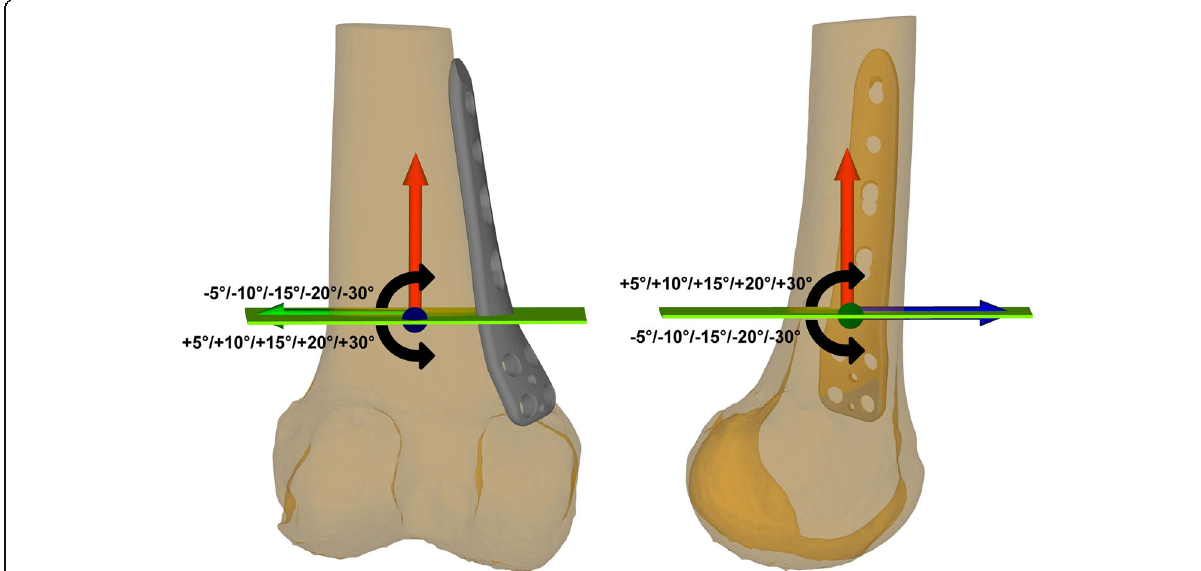
Fig. 3 Mal-angulation of the osteotomy planes. Mal-angulation of the baseline osteotomy plane was performed along the standardized coordinate systems in the frontal plane around the x-axis (blue) and in the sagittal plane around the z-axis (green) in steps of +/ − 5°, +/ − 10°, +/ − 15°, +/ − 20°, +/ −